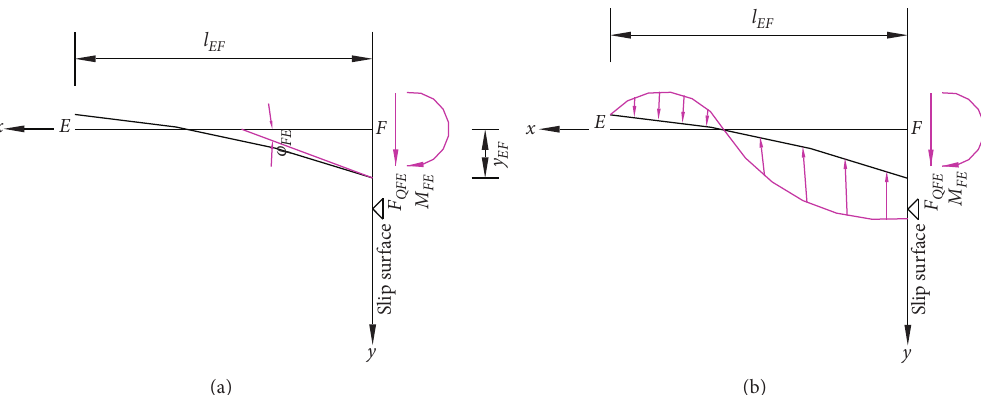
Figure 10: The initial effects and stress diagram of AB (elastic member): (a) the initial effects of AB (elastic member); (b) the stress diagram of AB (elastic member).